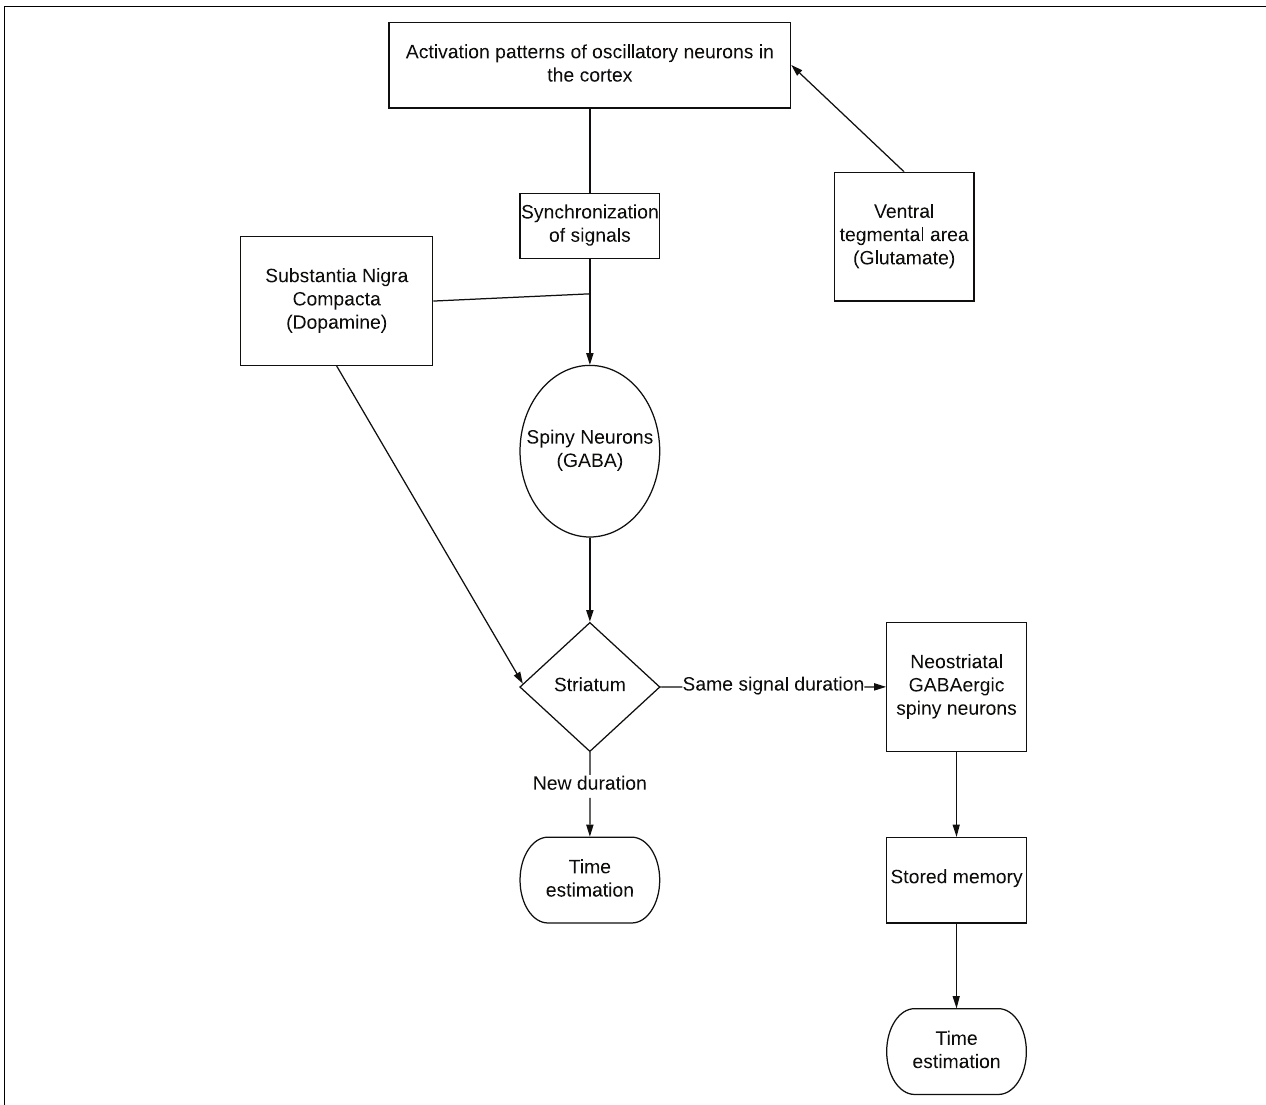
FIGURE 2 | The neural regions associated with time perception and timing behavior as outlined by the striatal beat frequency model.